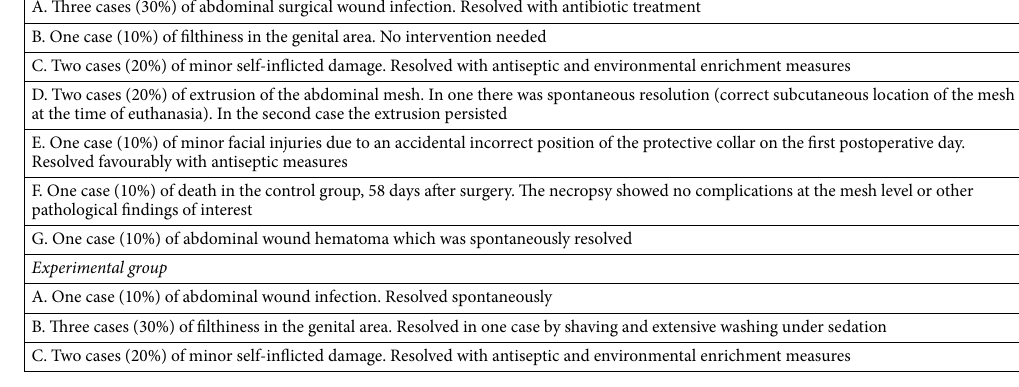
Table 2. Incidences at